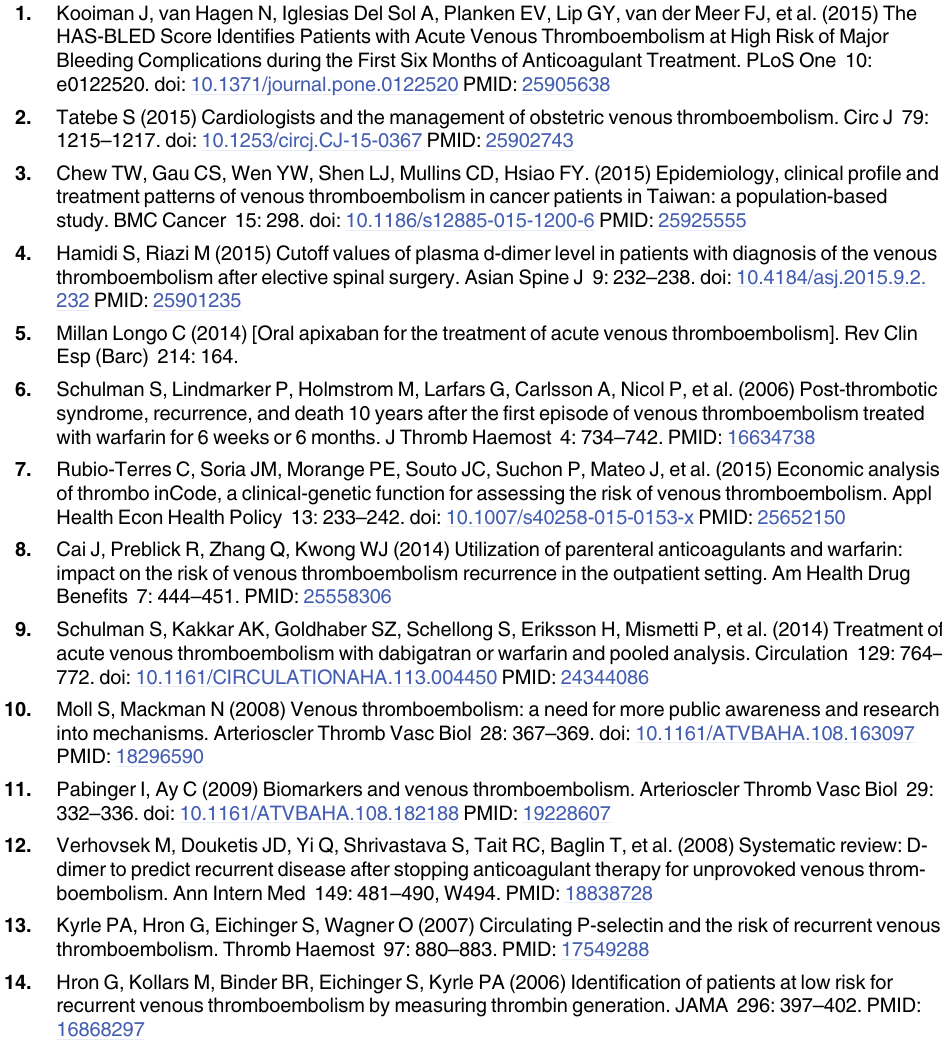
S4 Table. The top 200 candidates of three methods on ten function categories. S5 Table. The top 200 candidates among three methods at four pathways. S6 Table. The literature validation among four parameter combinations for top 200 candi-